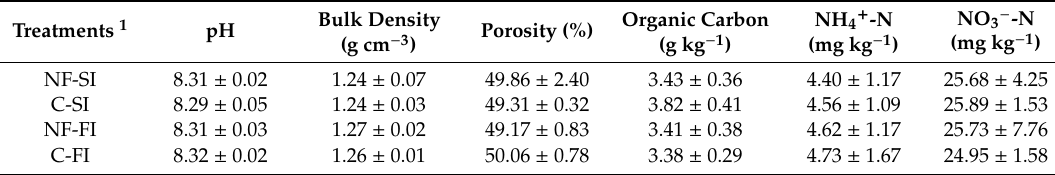
Table 2. Physicochemical properties of the soil before the experiment for treatments from two irrigation